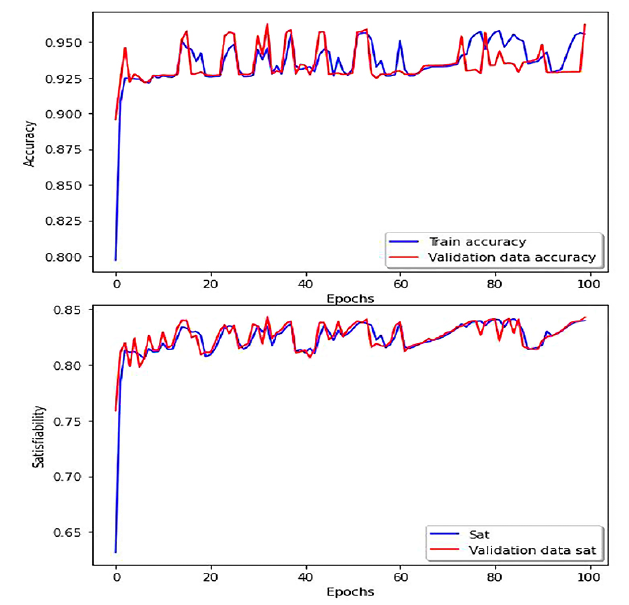
Figure 6. Evolution of satisfiability and accuracy in training LTN model.